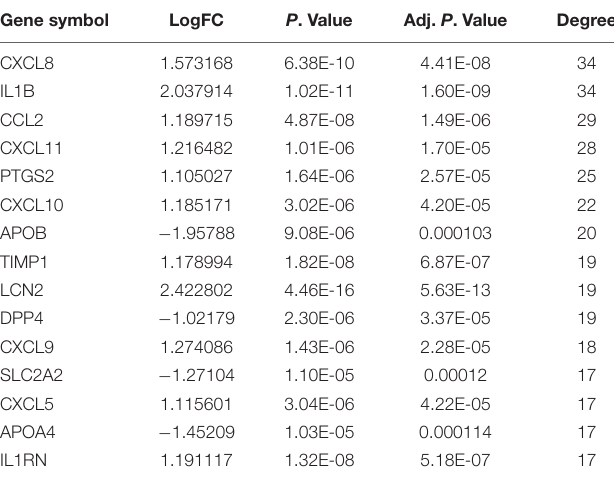
TABLE 1 | The expression analysis of the top 15 hub genes with the highest interaction degree. Gene symbol